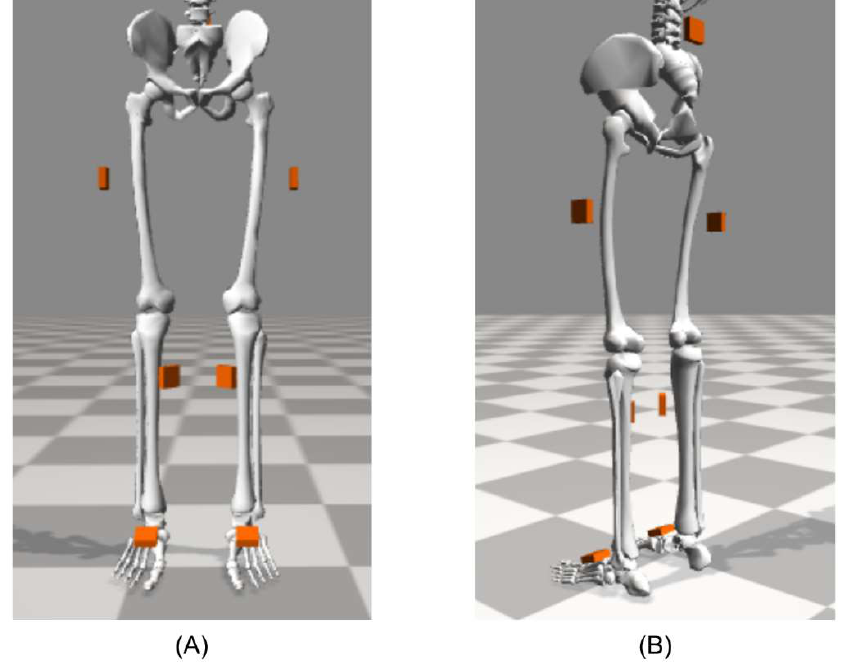
Figure 1. Seven-body model of the lower limbs consisting of the pelvis, thighs, shanks, and feet; visualized using OpenSim. ( A ) Front and ( B ) back views. Orange boxes represent IMU locations. Note that while OpenSim’s Gait2354 skeletal model is used here for visualization, the ErKF method treats each segment as an independent body possessing six degrees of freedom.